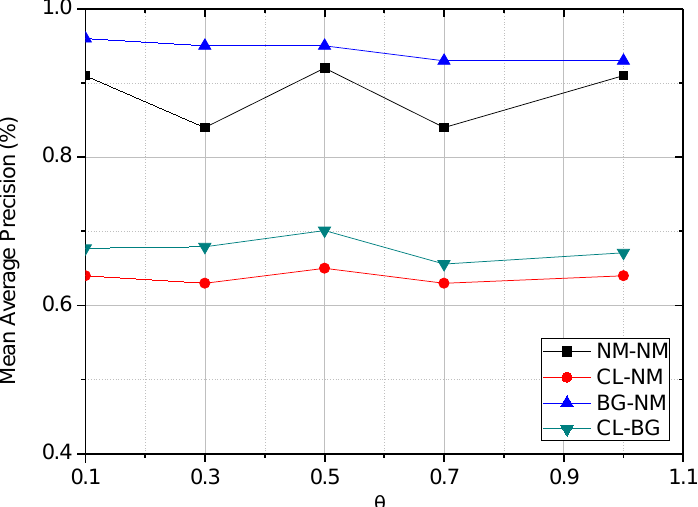
Figure 8. The mAP under the single condition and cross conditions with different values of θ .